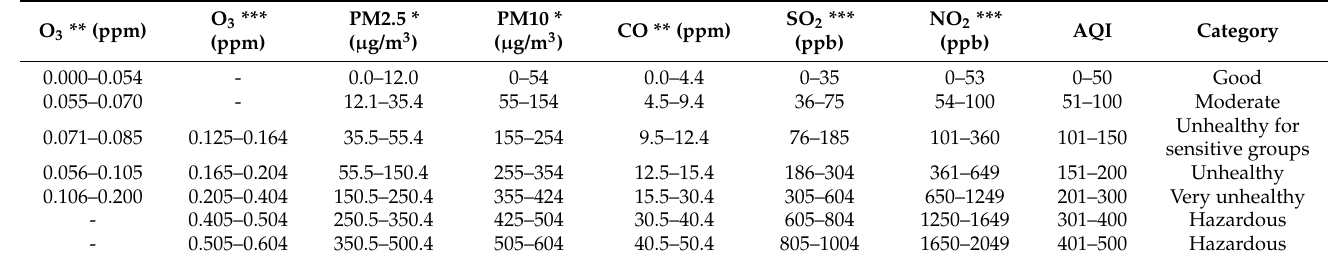
Table 1. AQI categories and their corresponding levels of air pollutants. Adapted from [24].